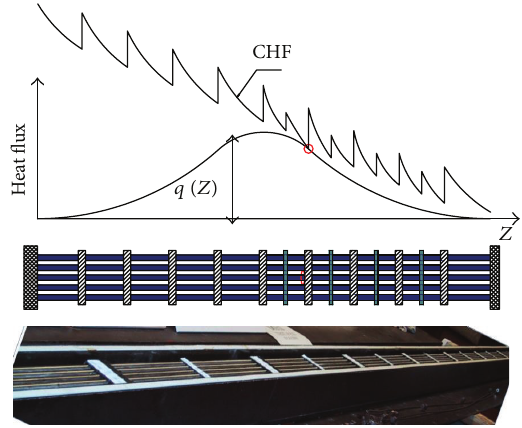
Figure 3: Rod bundle CHF with nonuniform APD. With the example of cosine axial power distribution, under normal operating condition and similar mixing vane grid and similar grid span at each elevation, the CHF mostly occurs near 2/3 elevation of the entire heated length.